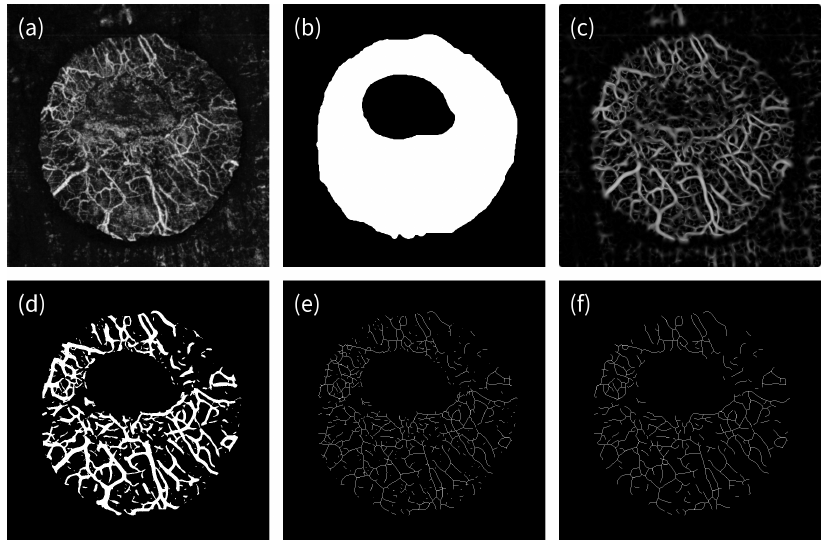
Figure 1. Post-processing of the optical coherence tomography angiograms. ( a ) Original OCT angiogram. ( b ) Region of interest with excluded wound area and image area covered by the plastic ring. ( c ) Angiogram after application of the Sato filter of curvilinear structures. ( d ) Thresholded angiogram. ( e ) Angiogram after skeletonization. ( f ) Skeletonized angiogram after removal of short vessel segments as used for calculating the vessel